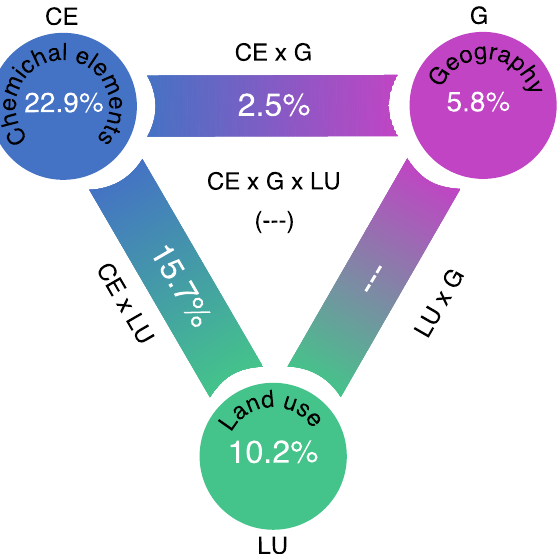
Figure 7. Variation partitioning analysis of microbial community explained by chemical elements characteristics (CE), land-use (O), and geographic location (G). Diagram represents the biological variation partitioned into the relative effects of each factor or a combination of factors. The edges of the triangle represent the variation explained by each factor alone. The sides and the middle of the triangles represent interactions of the factors.